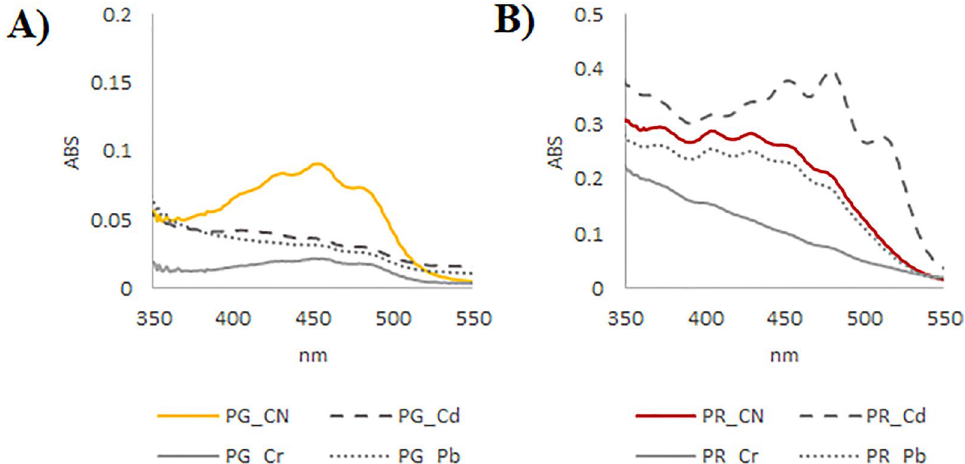
Figure 1. UV–Vis spectra of lipophilic extracts. UV–Vis spectra of lipophilic extracts of PG ( A ) and PR ( B ) samples (CTR = plants grown in uncontaminated soils; Cd, Cr, Pb = plants grown in soils experimentally contaminated by cadmium, chromium and lead). The software used to generate this figure was PeakView— Analyst TF